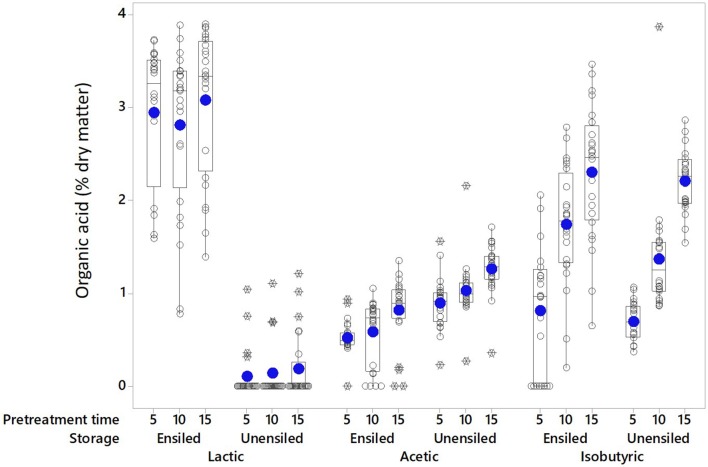
The main pretreatment acids in extracts of unwashed stover are shown at the various pretreatment retention times without regard to moisture levels. Solid circle = Mean; open circle = Individual values; Rectangle = Interquartile range; X = Outliers (extreme deviation from other observations; identified and calculated in the boxplot graphing tool as at least 1.5 interquartile ranges from edge of box).